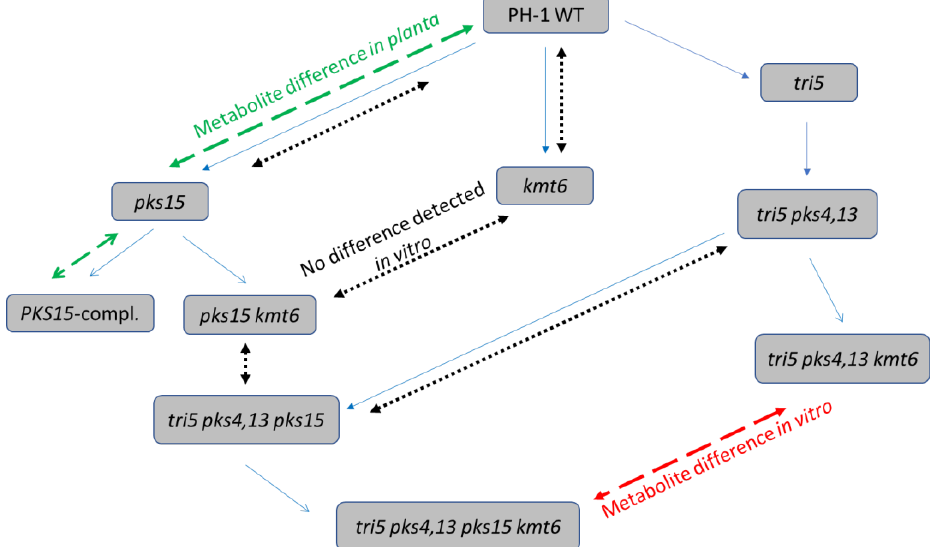
Figure 1. Overview of the generation of F. graminearum knockout strains and observed metabolite differences. Blue arrows indicate the strain genealogy (order of gene disruptions). Dashed arrows indicate the results of metabolite comparisons (Red: difference in vitro. Green: difference in planta . Black: no difference in vitro detected).